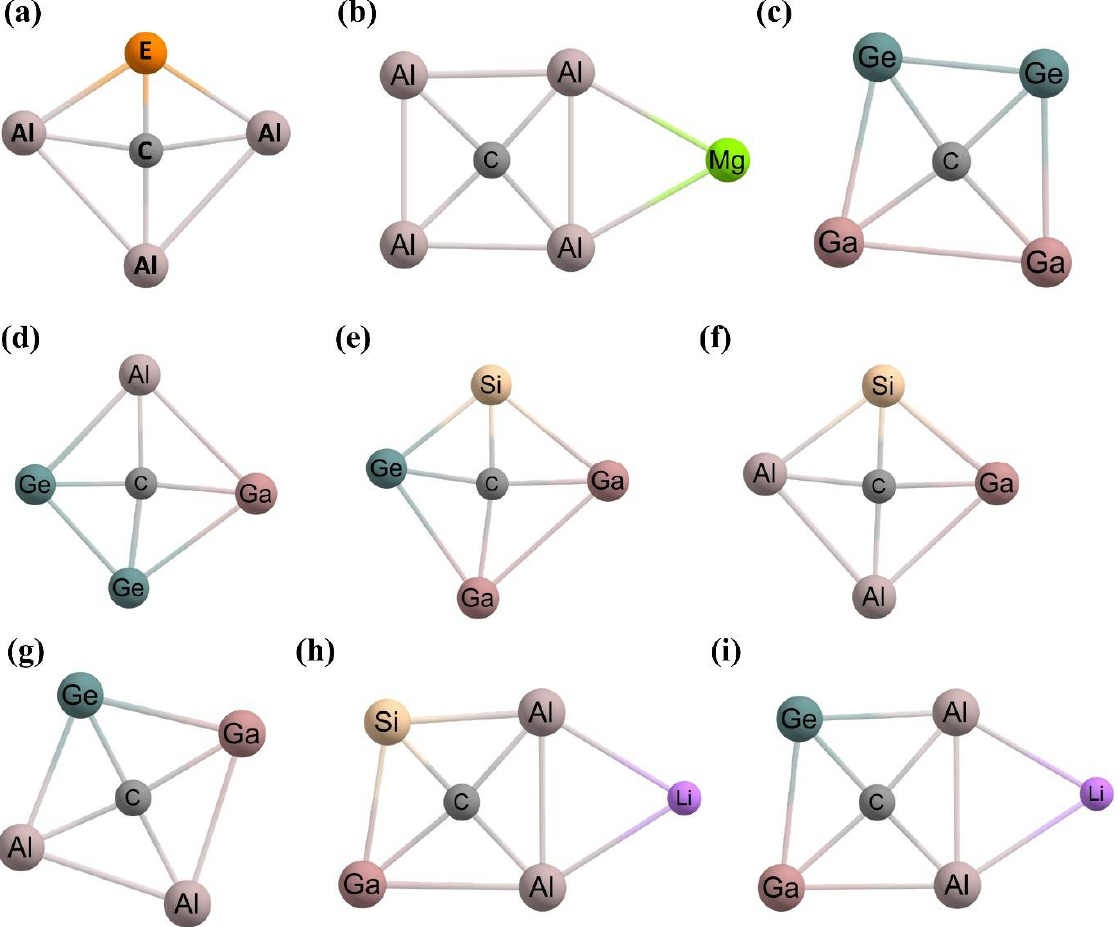
Figure 6. ( a ) Global minimum structures of the CAl 3 E (E = P, As, Sb, Bi) clusters. ( b ) The global minimum structures of CAl 4 Mg and CAl 4 Mg − clusters. The neutral and anionic forms have the same shape but different bond lengths. The minimum energy structures of ( c ) CGa 2 Ge 2 , ( d ) CAlGaGe 2 , ( e ) CSiGa 2 Ge, ( f ) CSiGaAl 2− , ( g ) CGeGaAl 2− , ( h ) Li@SiGaAl 2 , and ( i ) Li@GeGaAl 2 clusters.